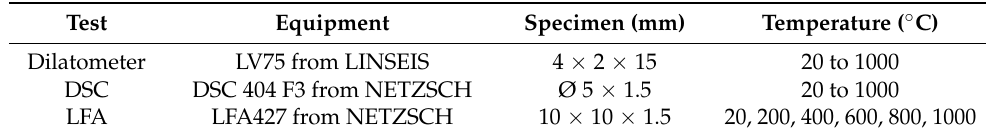
Table 2. These tests were performed to determine the following respective quantities: CTE, specific heat capacity ( c p ) and thermal conductivity ( λ ). All the tests were performed under Ar atmosphere. Table 2. Overview of thermophysical tests and testing conditions. Test Equipment Specimen (mm) Temperature ( ◦ C) Dilatometer LV75 from